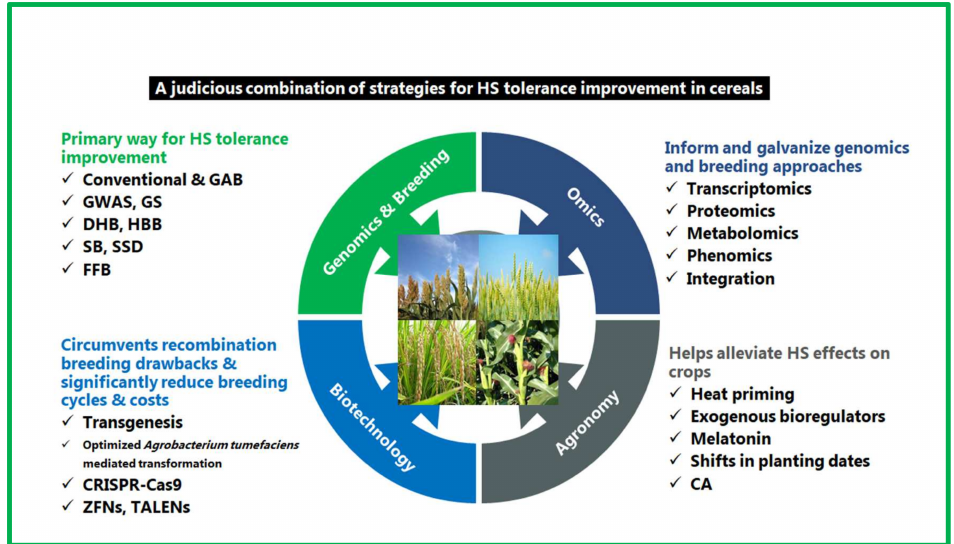
Figure 3. A multi-pronged approach for reproductive-stage HS tolerance improvement in